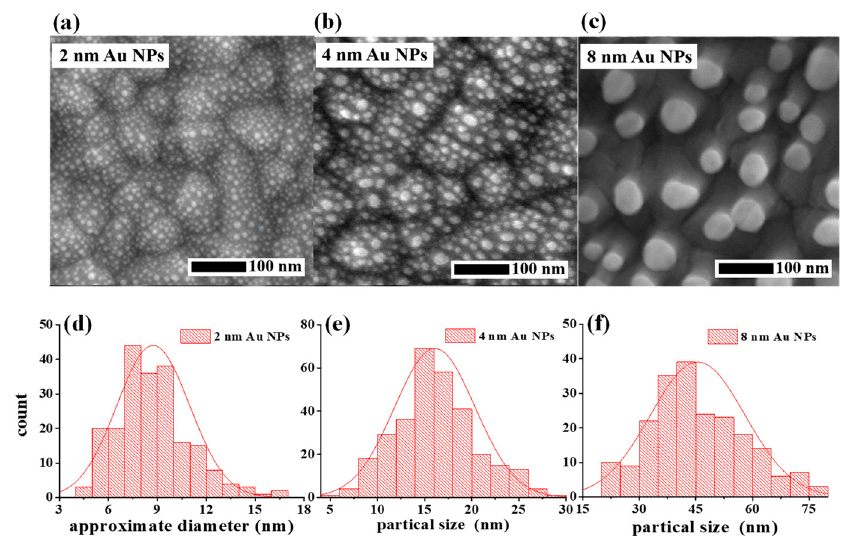
Figure 4. ( a – c ) Top-view SEM images of the FTO/TiO 2 /Au NP multilayer samples when the nominal thickness t n of the Au film subjected to the thermal treatment is tuned. ( d – f ) Histograms of the average size of the Au NPs with tuned t n .